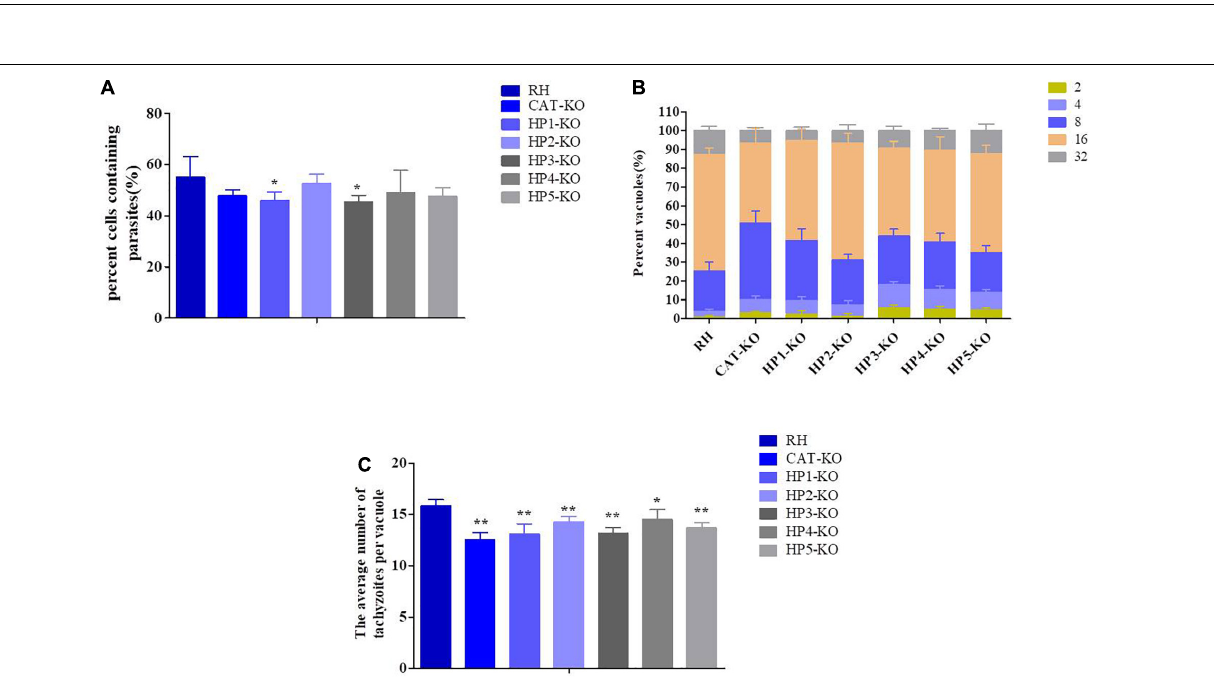
Frontiers in Microbiology |